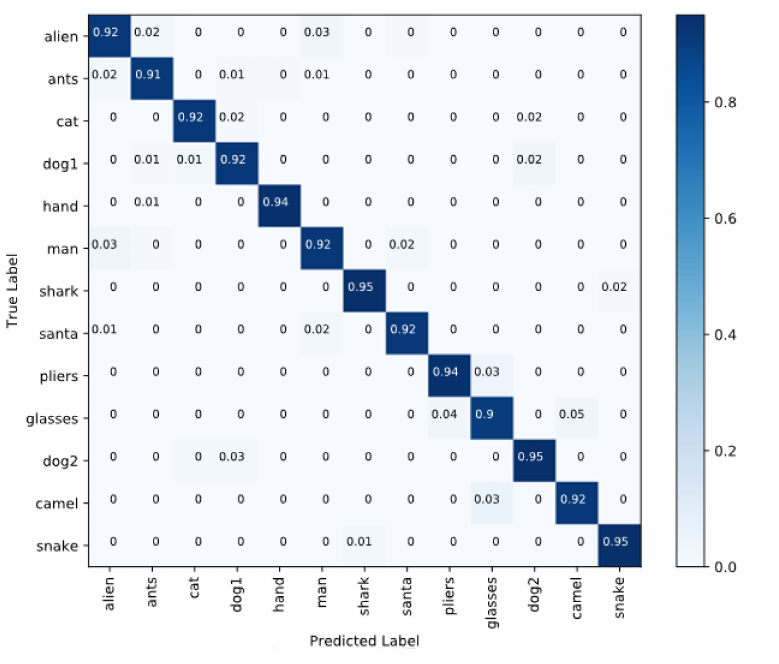
Figure 6. Convergence graph of each